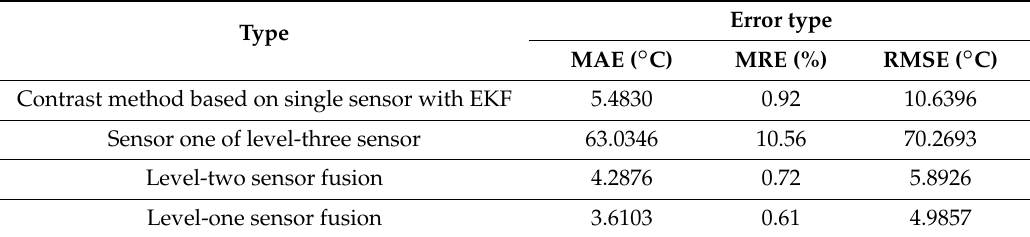
Table 2. MAE, MRE, and RMSE of the contrast method, sensor one of level-three, level-two, and level-one sensors for the simulation case.